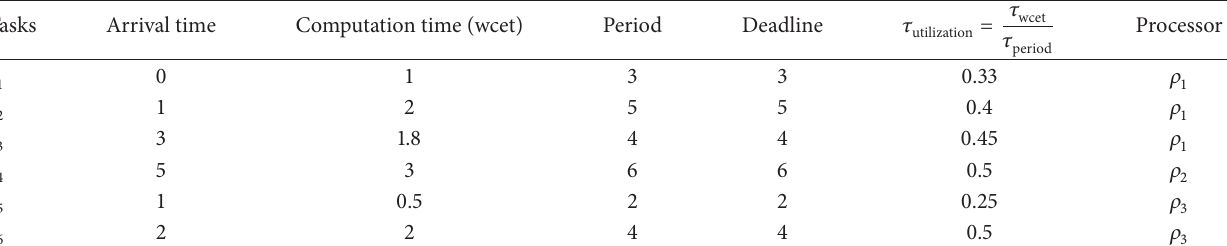
Table 3: Arrival time, wcet, period, deadline, and node for assignment of tasks 𝜏 1 , 𝜏 2 , 𝜏 3 , 𝜏 4 , 𝜏 5 , and 𝜏 6